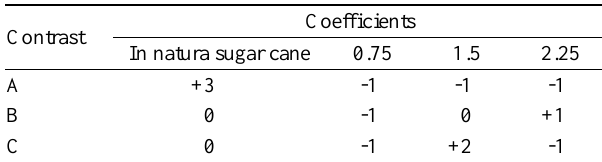
for decomposition of the square sum for the